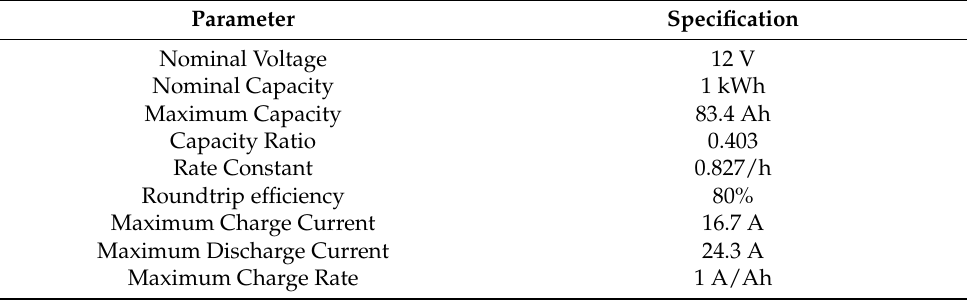
Table 2. Parameters of lead-acid batteries used in simulation in HOMER